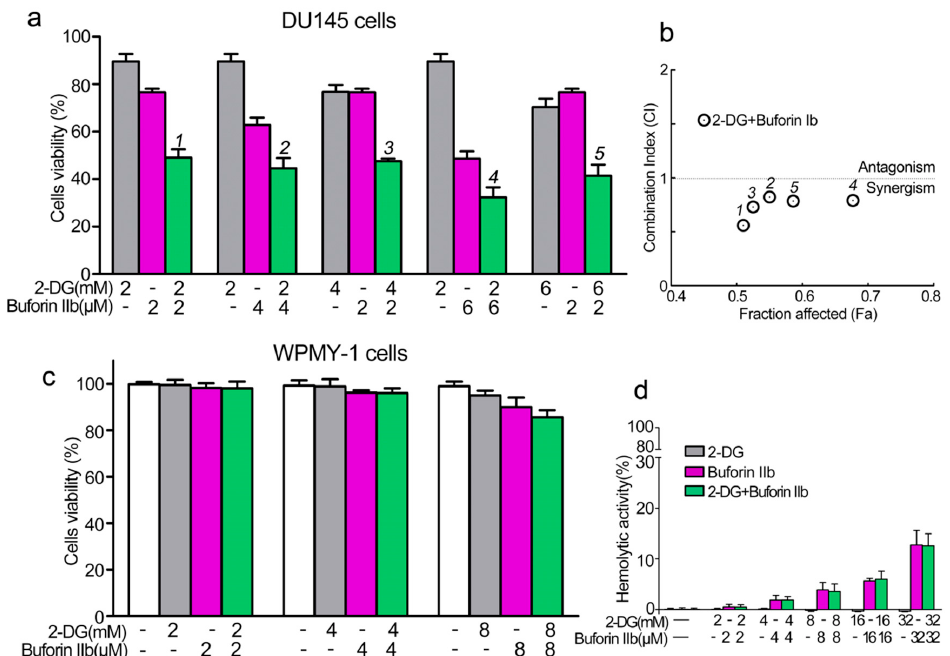
Figure 1. E ff ects of 2-DG and buforin IIb alone or in combination on prostate cancer and normal cells. ( a ) Cell viability in the prostate cancer cell line DU145 was assessed using the CCK-8 assay following 2-DG and / or buforin IIb treatment for 24 h. ( b ) The combination index (CI) of treatment with 2-DG and buforin IIb was measured by Compusyn software. ( c ) Cell viability in the normal prostatic epithelial WPMY-1 cell line. ( d ) Hemolytic activity was tested in mouse erythrocytes. The results are expressed as the mean ±SEM of 4–6 independent experiments.